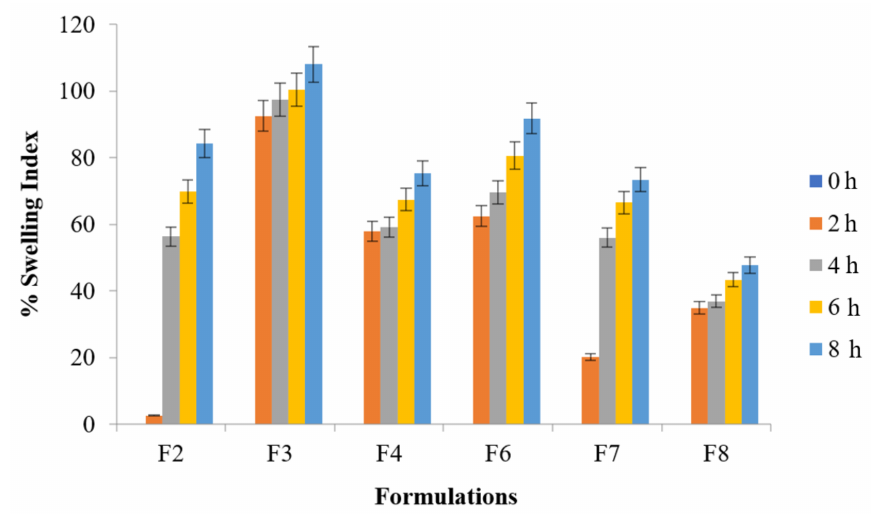
Figure 3. % Swelling index of metronidazole tablet ( p < 0.001) F3 vs. F8 ( p < 0.05) F3 vs. F2, F4, and F7.